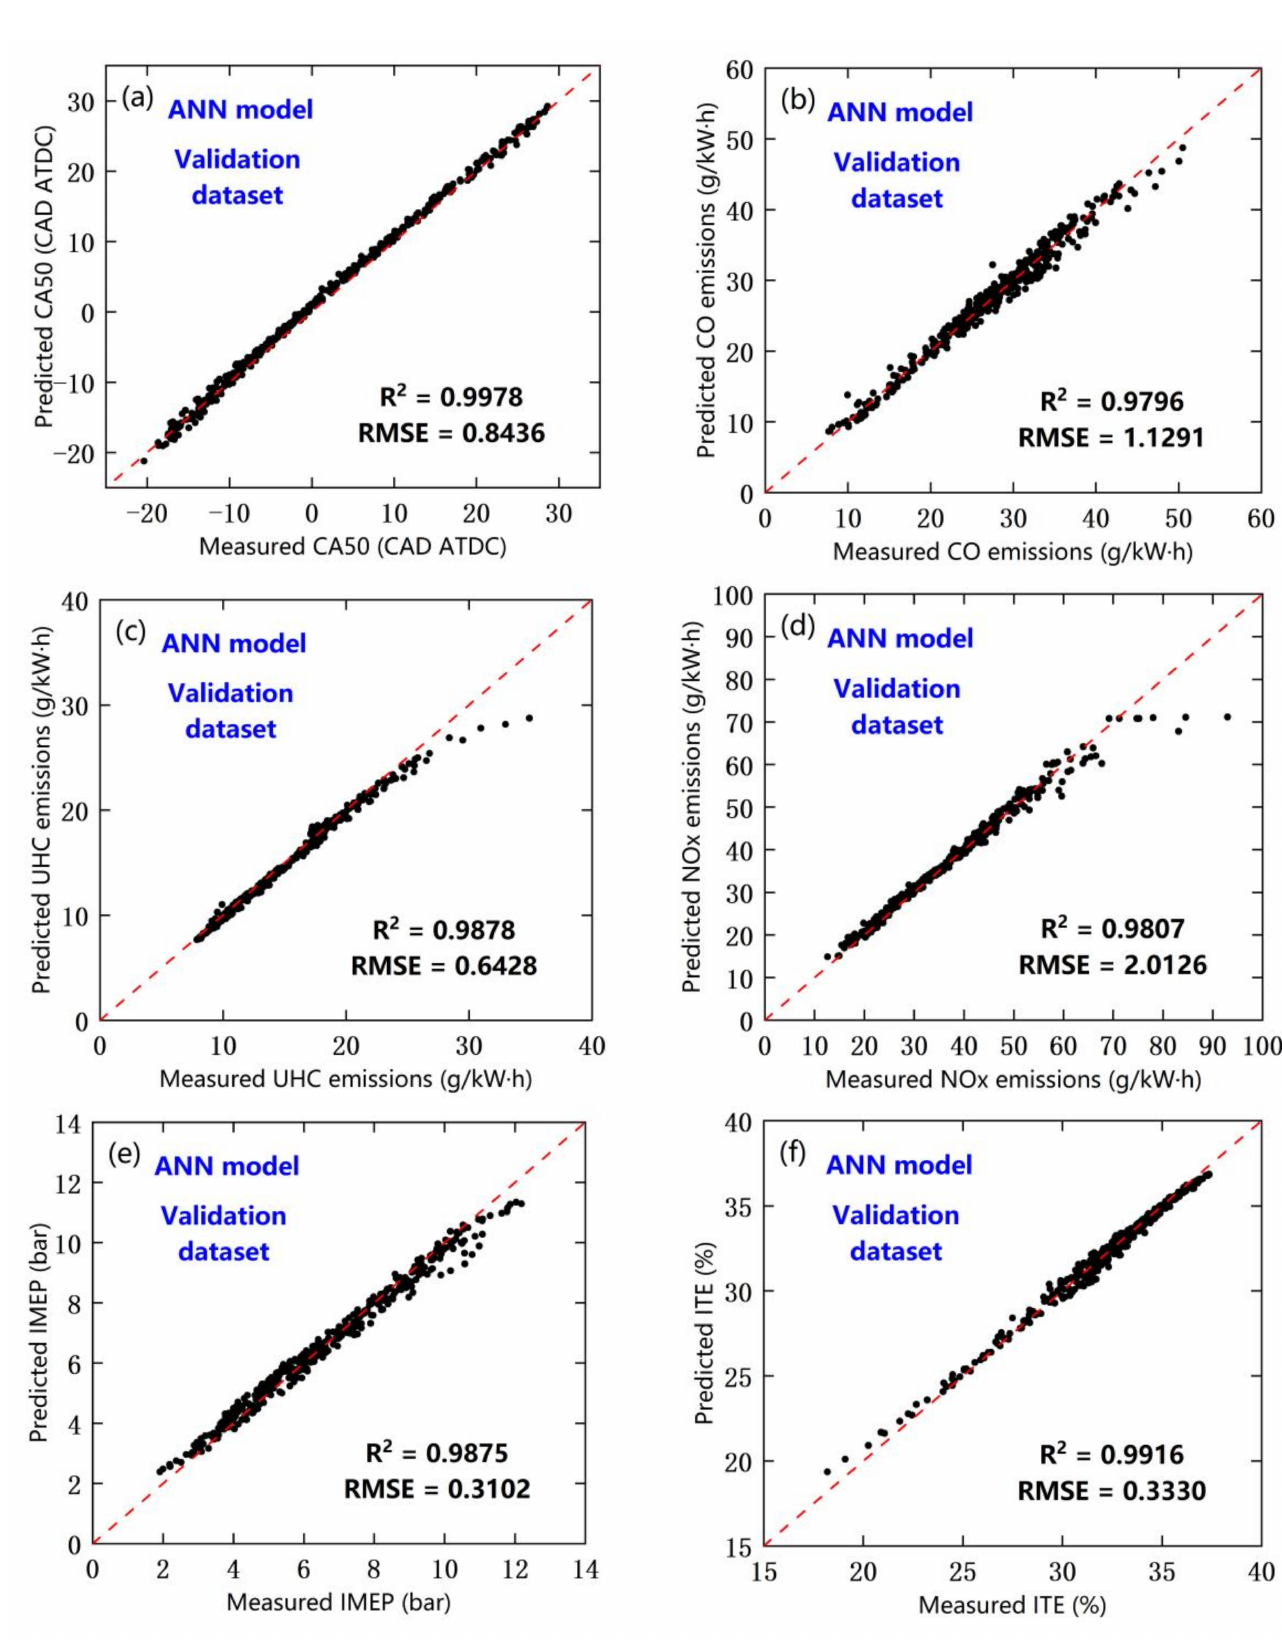
Figure 4. Comparison of ANN predicted performance and emissions with actual value for the validation dataset: ( a ) CA50, ( b ) CO, ( c ) UHC, ( d ) NOx, ( e ) IMEP, ( f )